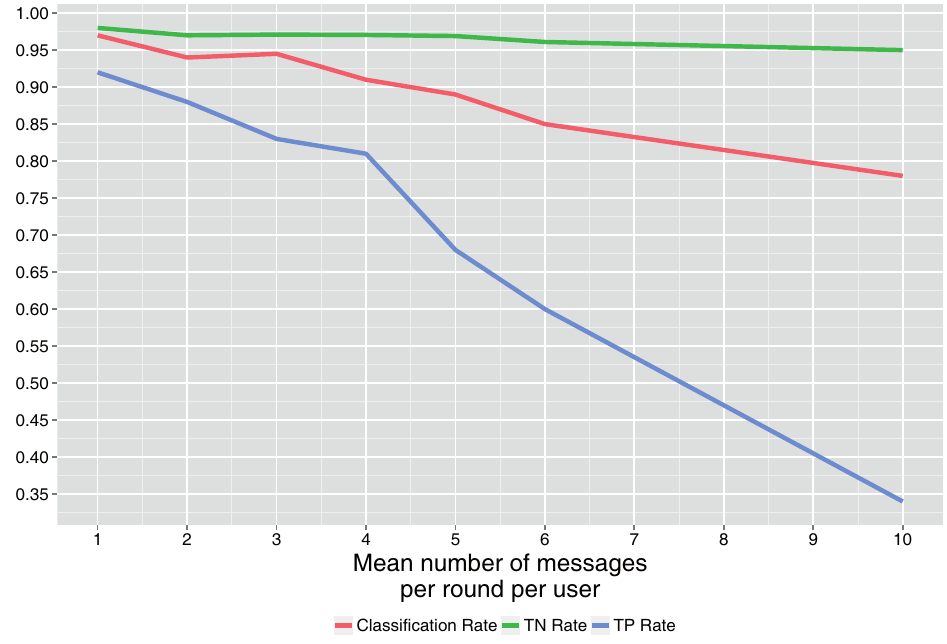
Figure 7. Classification rates vs. the mean number of messages per round.